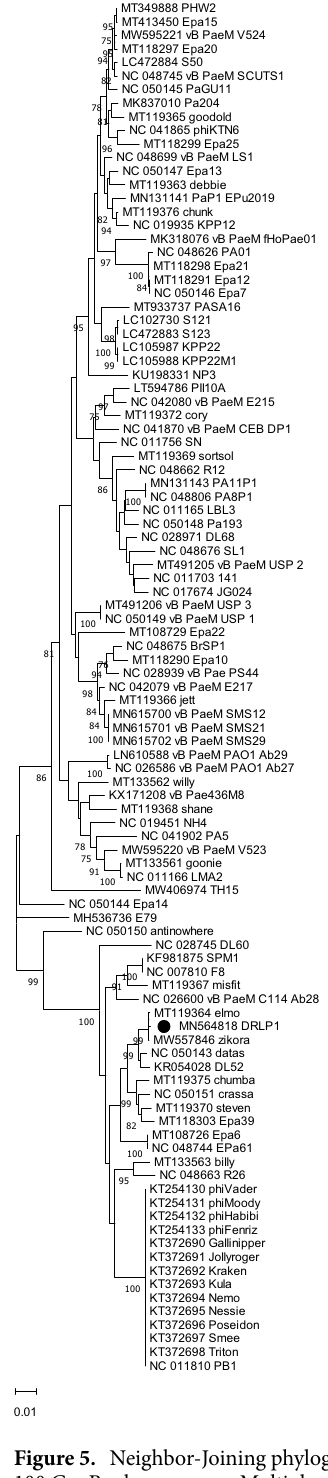
Figure 5. Neighbor-Joining phylogenetic tree based on the DNA pol III sequences from DRL-P1 and related 100 GenBank sequences. Multiple sequences were aligned using the MAFFT online server. Evolutionary distances were calculated using the Maximum Composite Likelihood method implemented in MEGA X computer program. Numbers below the branches represent percentage of replicate trees, where the associated taxa clustered together during the bootstrap test (1000 replicates). The optimal tree is drawn to scale with branch lengths signifying the evolutionary distances used to infer the tree. A total of 3111 positions were available in the final dataset for evolutionary analyses. Ambiguous positions were excluded from analysis. Graphical presentation of the phylogeny was generated using the MEGA X computer program, version 10.2.4 (https:// www. megas oftwa re.